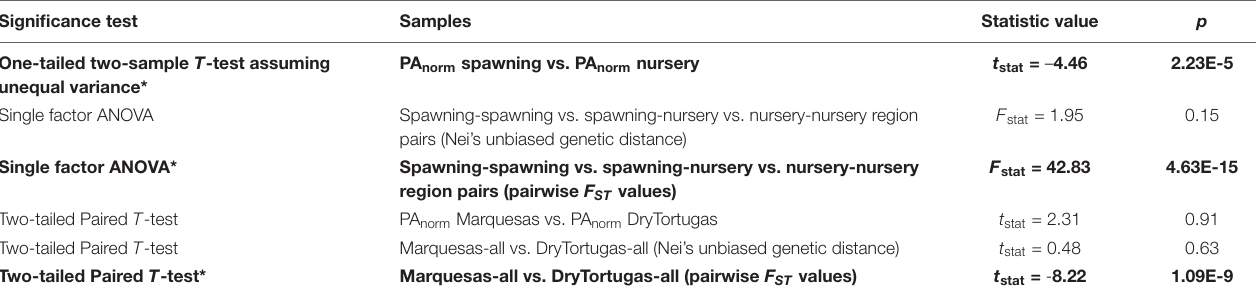
TABLE 4 | Results of all significance tests comparing region types (spawning vs. nursery), region-pair types (spawning-spawning vs. spawning-nursery vs. nursery-nursery region pairs), and spawning regions (Marquesas vs.